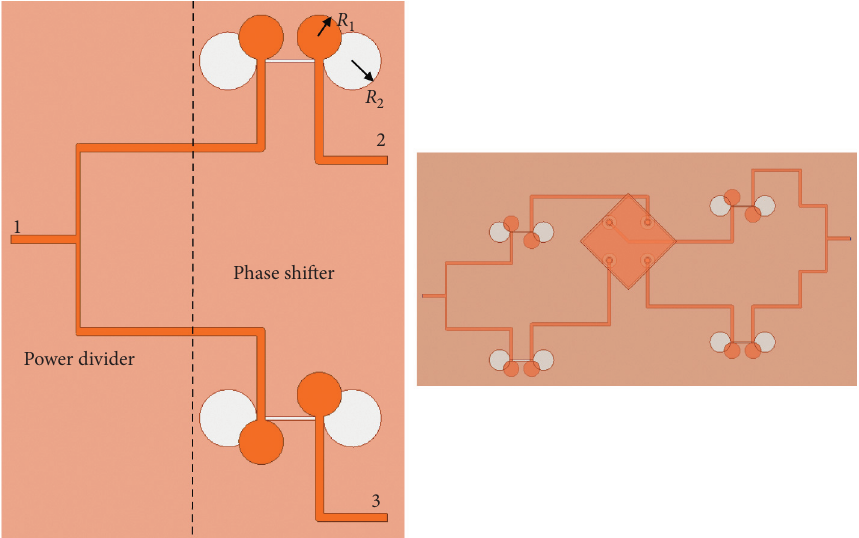
Figure 10: Configuration of the feeding